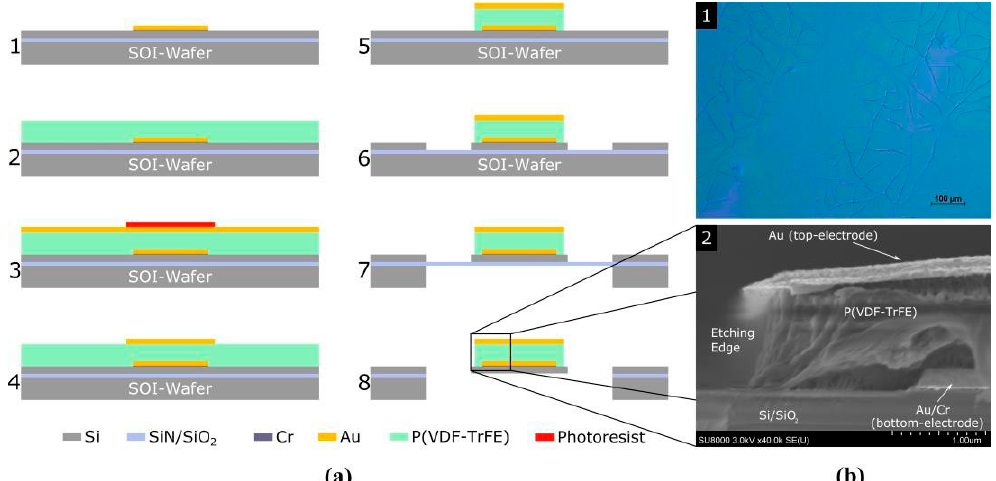
Figure 1. Fabrication of organic MEMS devices: ( a ) Process flow of P(VDF-TrFE) based cantilevers: (1) Bottom electrode patterning (lift-off process), (2) Spin coating of P(VDF-TrFE), (3–4) Top electrode patterning (wet chemical etching), (5) O 2 -etching of P(VDF-TrFE), (6–8) Frontside and backside deep reactive-ion etching and HF-release; ( b ) (1) Large cracks all over the P(VDF-TrFE) layer after a lift-off process caused by the solvent PGMEA of the photoresist, (2) SEM image of the cut through an organic